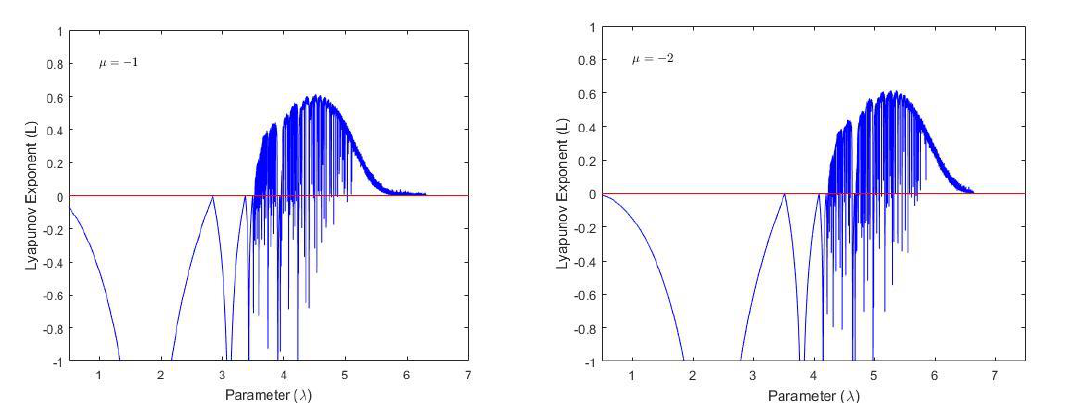
Figure 12. Lyapunov exponents for μ = − 1 Figure 13. Lyapunov exponents for μ = − 2